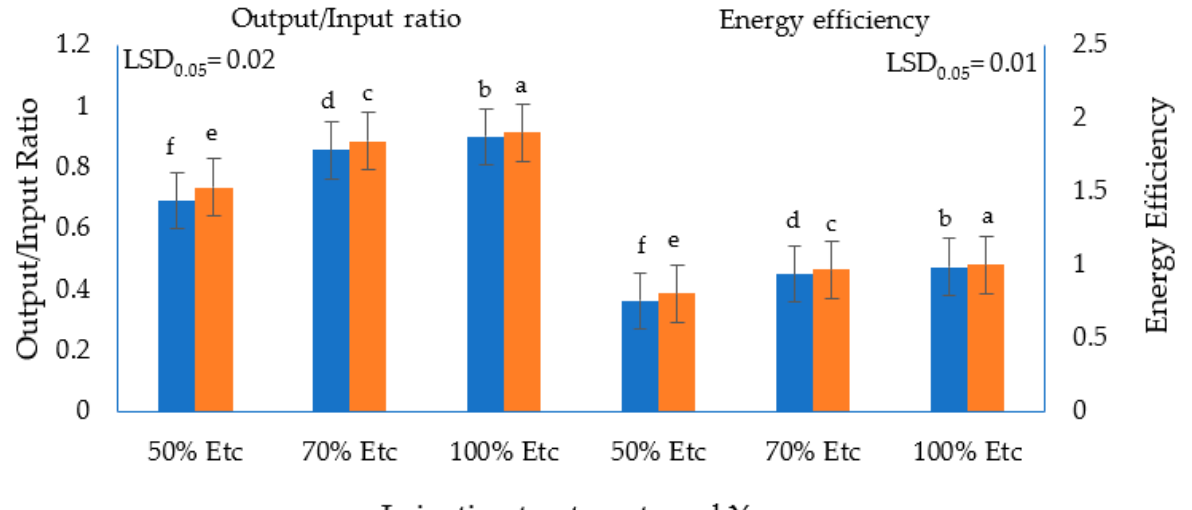
Figure 2. Output/Input ratio and energy efficiency in maize cultivation the two years, 2019 and 2020. Data presented are mean values, where LSD 0.05 is the Least Significant Difference at the 0.05 significance level. Notes: 50% ET c : 50% evapotranspiration; 70% ET c : 70% evapotranspiration; 100% ET c : 100% evapotranspiration (control). Within each year and within each treatment, different letters above the bars correspond to statistically significant difference between the means compared. Error bars correspond to the Standard Errors of the mean